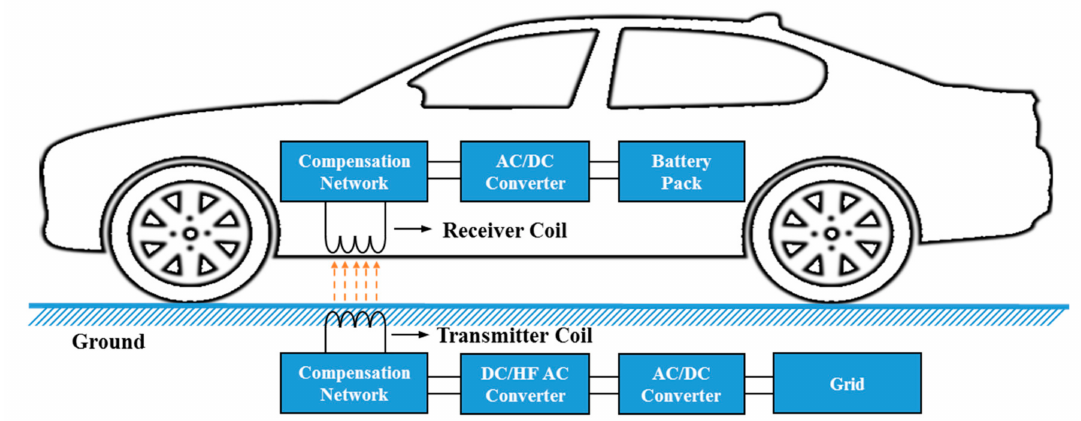
Figure 1. Structure of a typical inductive power transfer system for electric vehicle (EV)